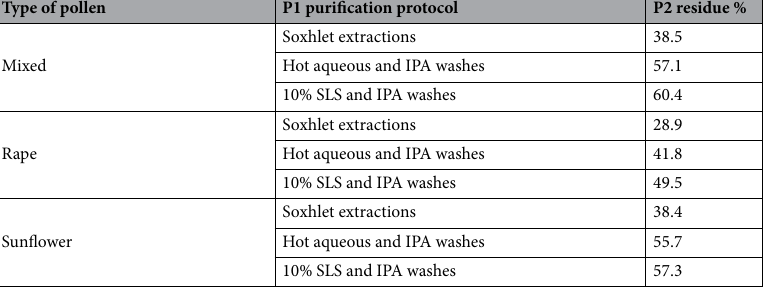
Type of pollen P1 purification protocol